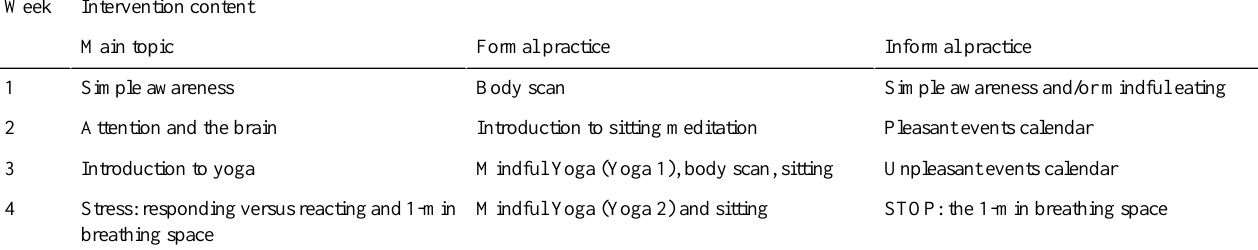
Table 1. Weekly content in the 8-week online mindfulness-based stress reduction intervention. Intervention